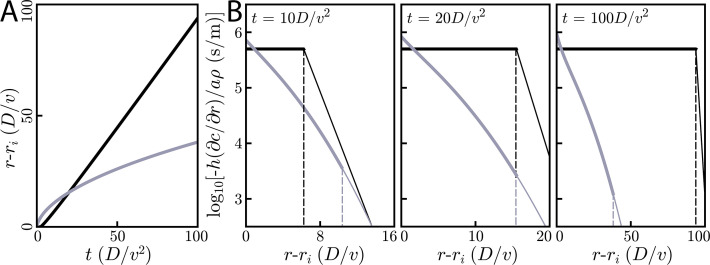
Comparison of relay and simple diffusion for cells and diffusion in 2D.All plots are for D=10-10 m2/s, v=2 µm/s, and ri=4⁢D/v. (A) Information fronts for relay (black) and simple diffusion (gray) models. The information wave travels like t for simple diffusion and v⁢t for the relay. The threshold concentration for the simple diffusion model is chosen such that the its information front intersects the relay model at t=20⁢D/v2. Thus, hCth,relay/aρ=25 s while h⁢Cth,diff./a⁢ρ≈0.25 s. (B) Snapshots of radial gradients at various times for both the relay (black) and simple diffusion (gray) models. The dashed vertical lines indicate the location of the wave fronts. For short times (left) the relay’s information wave front lags behind the simple diffusion model’s information front, though it later catches up (middle) and passes it (right). At all times, for cells just inside the wave front, the relay model creates gradients that are orders of magnitude larger than does simple diffusion.